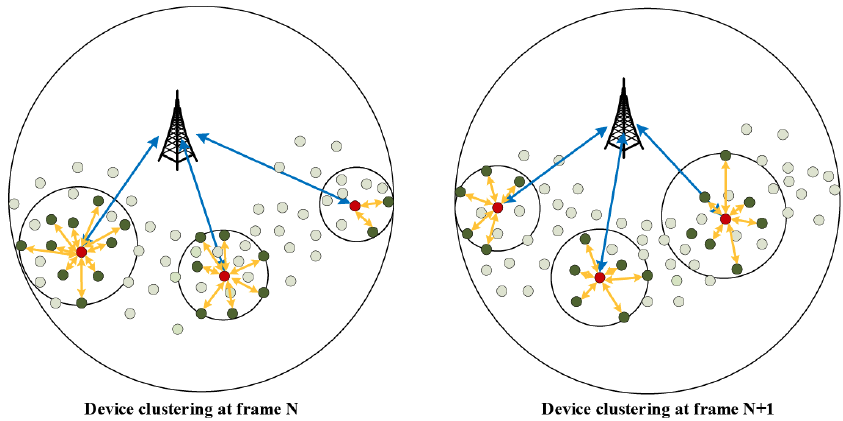
Figure 2. Adaptive clustering diagram range from the Nth frame to the N+1th frame.